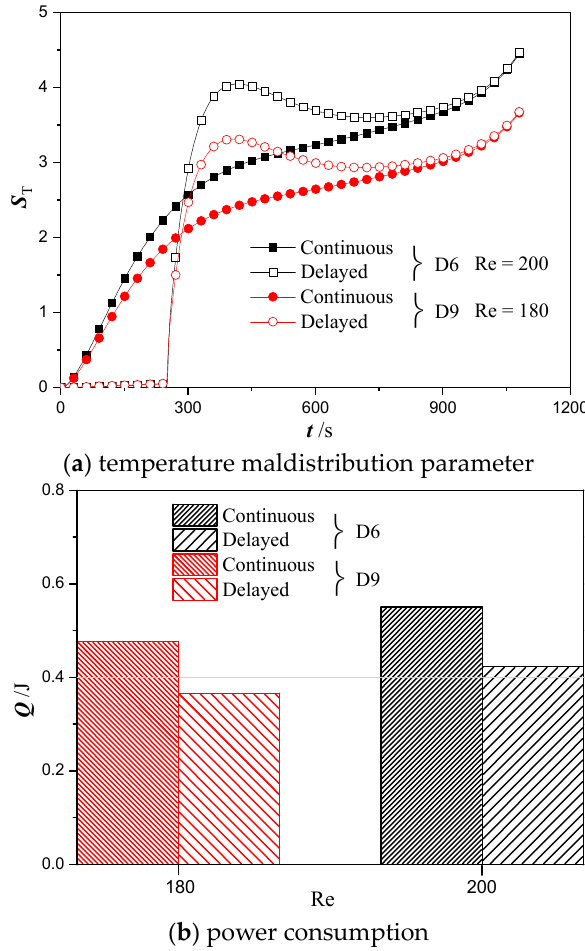
Figure 13. Temporal variation of power consumption for cold plate designs D6 and D9 with the average battery temperature controlled within the allowable range.